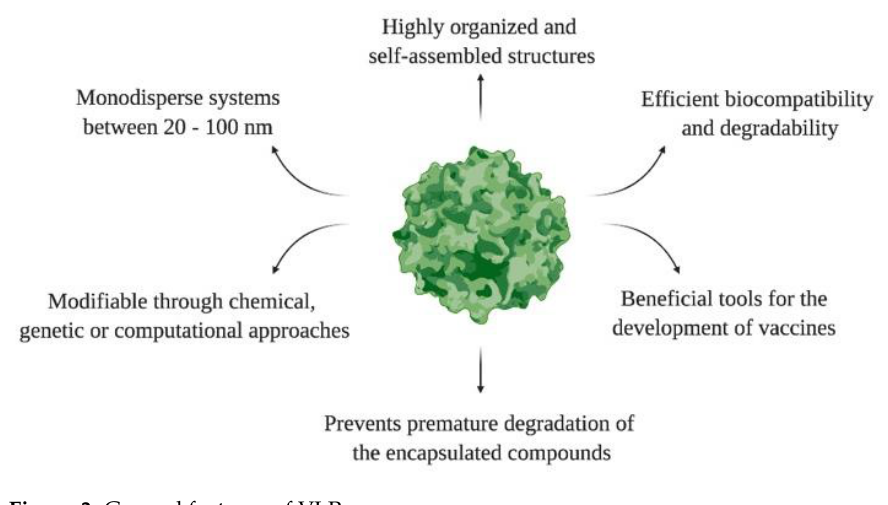
Figure 3. General features of VLPs.